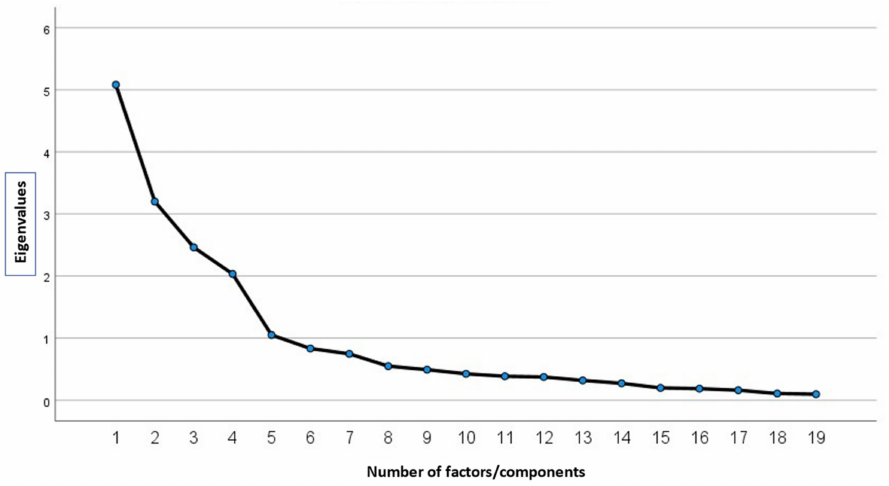
Figure 6. Result of the sedimentation of factors.